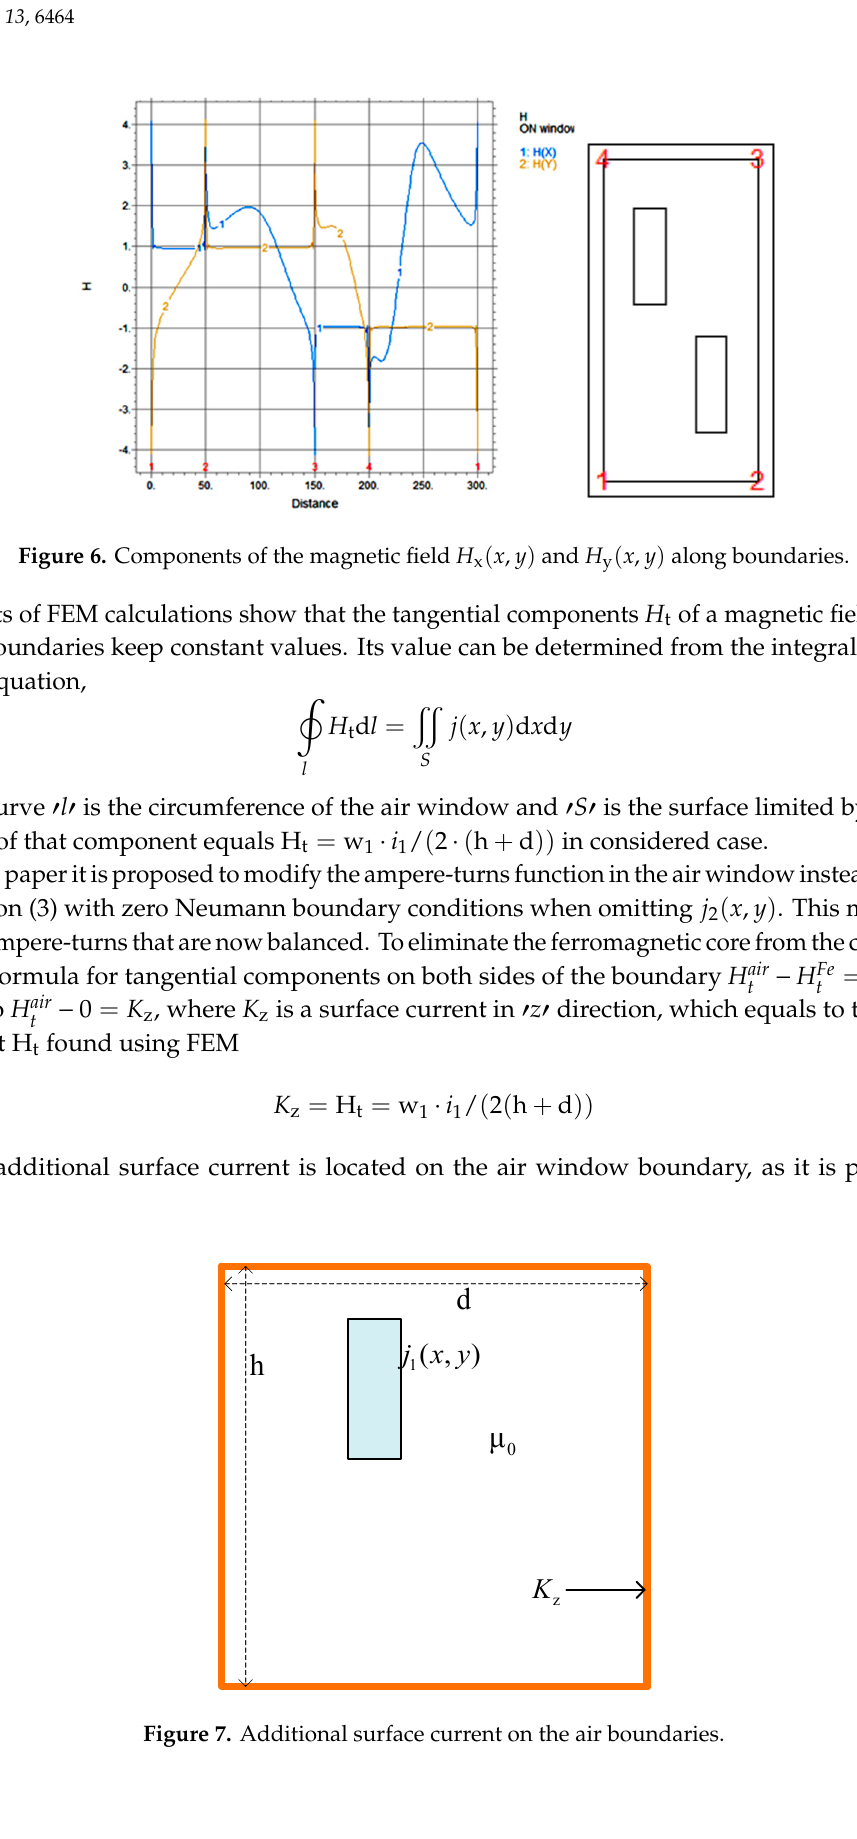
, H x y and ( ) , H x y along boundaries. x y